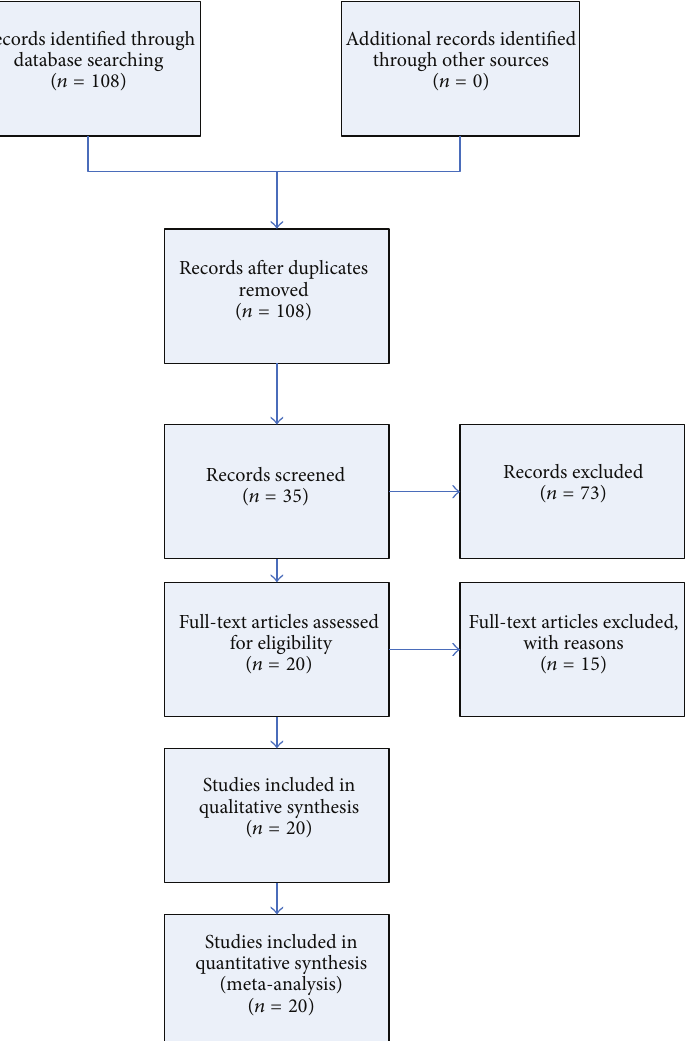
Figure 1: Study selection